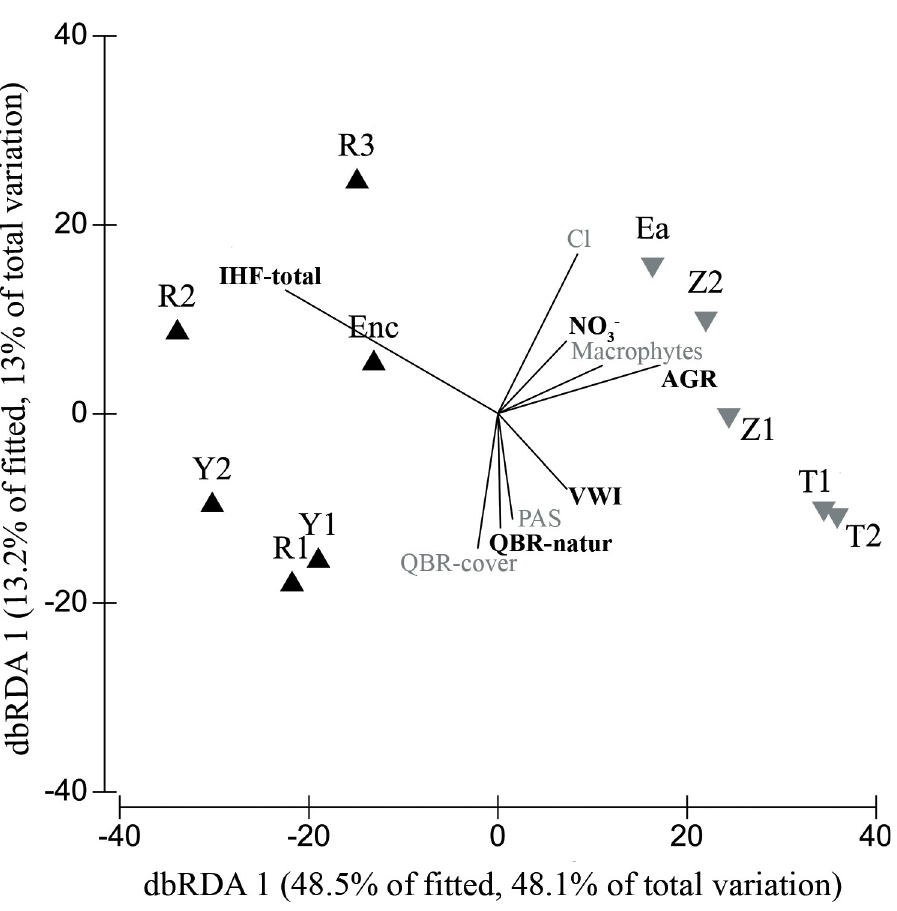
Fig 4. DISTLM analysis. DISTLM analysis showing the dissimilarities between the macroinvertebrate assemblages of the studied sites, and predictor variables included in the final model -significant variables (p < 0.05) are highlighted in bold-. Sites previously grouped by cluster analysis are shown with different symbols (black triangles: group 1; grey inverted triangles: group 2). IHF: Total score of the River Habitat Index; QBR-natur: component of the QBR referred to river channel alteration; NO 3- : nitrate concentration; Cl: chloride concentration AGR: area occupied by agricultural land upstream the study site; VWI: Valley Width Index or ratio of valley width to channel width; PAS: area occupied by pasture upstream the study